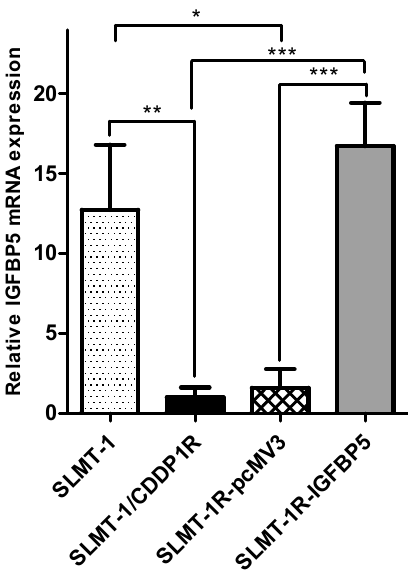
Figure 5. Relative mRNA expression levels of IGFBP5 in SLMT-1 parental cells, SLMT-1/CDDP1R, SLMT-1R-pcMV3 and SLMT-1R-IGFBP5.Significantly higher expression level of IGFBP5 was observed in SLMT-1R-IGFBP5 compared with the SLMT-1/CDDP1R and SLMT-1R-pcMV3 cells after normalization with the expression of β -actin in qPCR. *** p < 0.001, ** p < 0.05, * p < 0.01.